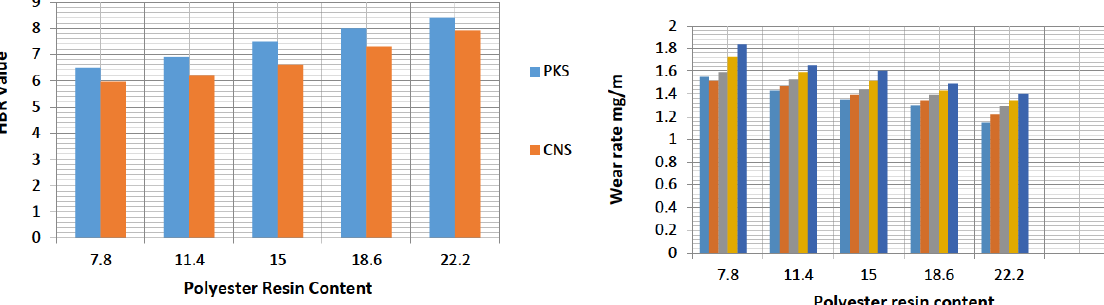
Figure 7: Wear rate of PKS /Polyester 250 µ m at 50 ∘ C